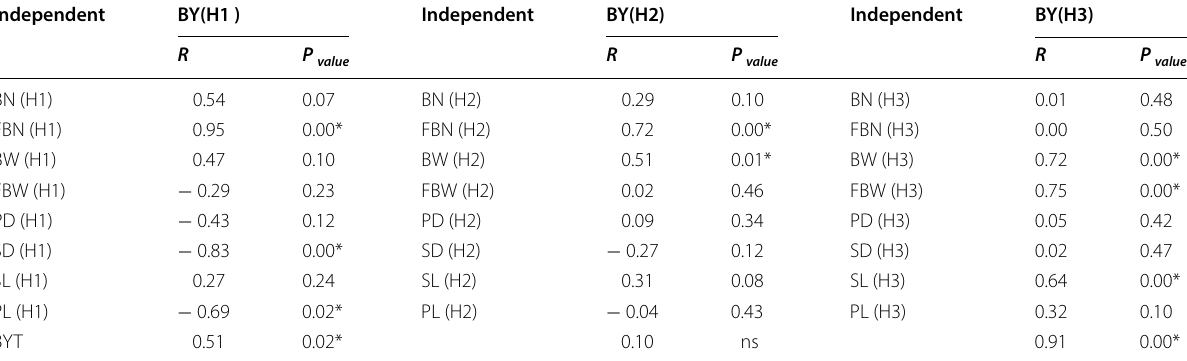
H: harvest, BY: biological yield, BN: bunches number, FBN: fruit body number, BW: bunches weight, FBW: fruit body weight, PD: pileus diameter, SD: stipe diameter, SL: stipe length, PL: pileus length, BYT: total biological yield * Significant correlation at the 0.05 level (1-tailed)